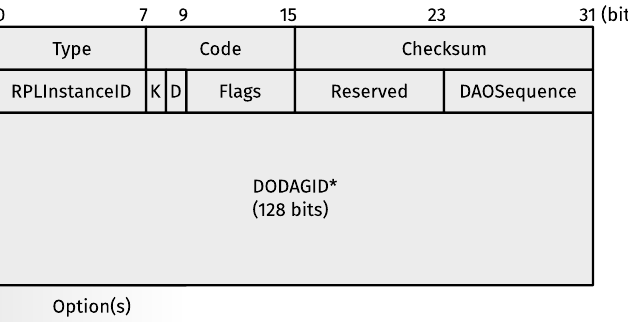
Figure 4. Format of an RPL Destination Advertisement Object (DAO). Note that a DAO is an ICMPv6 informational message with Type = 155 (RPL Control Message) and Code = 0x02 (DAO). The asterisk (*) indicates the absence of the DODAGID field in certain cases (see [4] (pp.